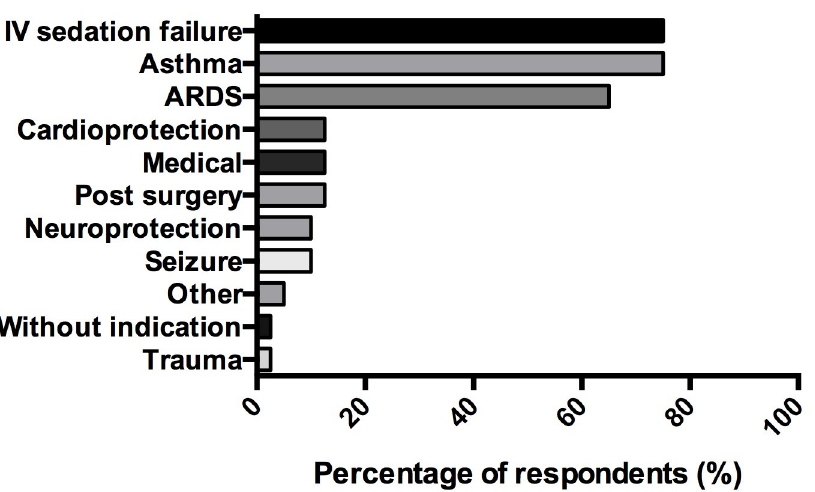
Fig 3. Indications of volatile anesthetics for intensive care sedation, as reported by users. (n = 40) Data are represented in % . ARDS : Acute Respiratory Distress Syndrome; IV : Intravenous .